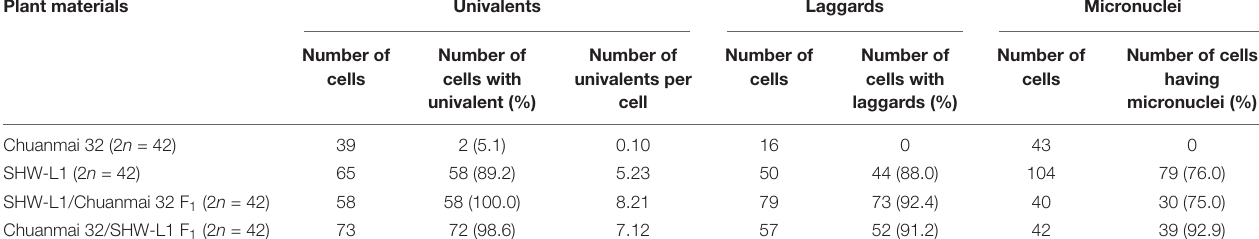
TABLE 2 | Meiotic features in euploid plants of synthetic SHW-L1 and its hybrids. Plant materials Univalents Laggards Micronuclei